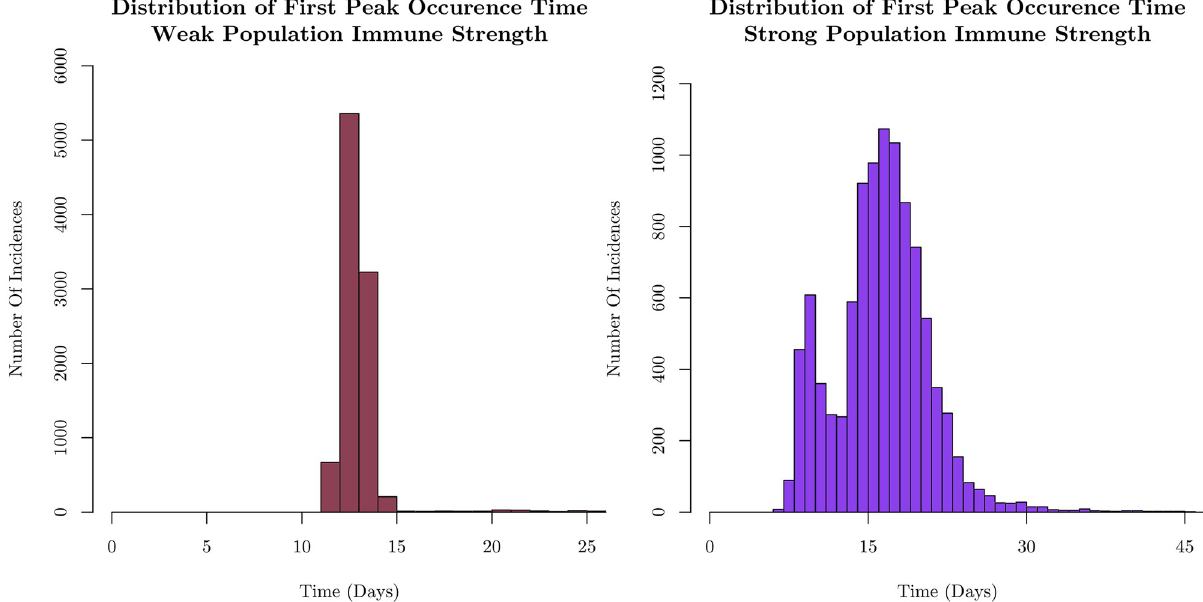
Fig 5. Distributions of the occurrence time of the first peak in the infected number. The results for a weak population immune strength corresponding to Fig 3 on the left, and for a strong population immune strength corresponding to Fig 4 on the right. For a population with weak immune strength, infection spreads rapidly throughout the initial cohort, leading to a narrow distribution of times for the peak. Rapid spread reduces variance in the timing of the peak due to the finite size of the cohort. Increasing the collective immune strength, as shown on the right, broadens the distribution reflecting the increased time to spread as well as the availability of fewer susceptible agents, leading to many pauses in infection spread throughout the cohort. The histograms each represent 10,000 sample simulations.